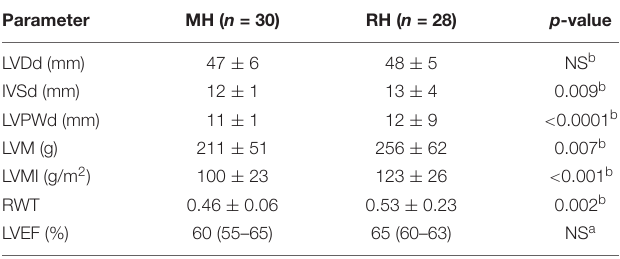
TABLE 3 | Echocardiographic parameters in MH and RH group.